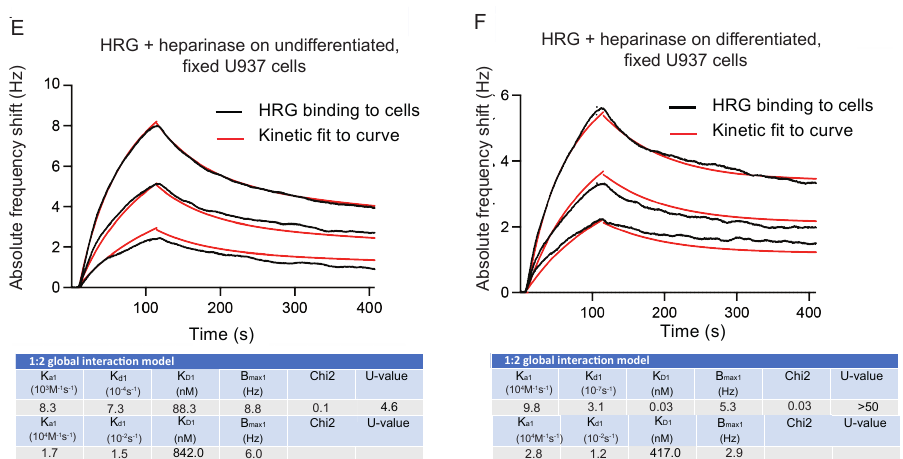
Figure 4. Affinity of HRG for binding to fixed U937 cells. ( A ) Sensorgram showing frequency response to inactive HRG over vitD3 differentiated, fixed U937 cells. ( B ) Sensorgram showing frequency response to four concentrations (125 nM, 250 nM, 500 nM, 1 µ M) of STC2 over fixed, undifferentiated (dashed lines) and vitD3 differentiated (straight lines) U937 cells. The mean of two injections is shown. ( C , D ) Sensorgram and kinetic analysis show the binding of HRG at three concentrations (25, 50 and 100 nM) to undifferentiated ( C ) or vitD3 differentiated ( D ), fixed U937 cells. Black lines: experimental curves. Red lines: fitted curves of the 1:1 interaction model. For representative sensorgrams shown, three injections per concentration, three independent experiments. ( E , F ) Sensorgram and kinetic analysis showing frequency response to three concentrations of HRG (25, 50 and 100 nM) to fixed, undifferentiated ( E ) or vitD3 differentiated ( F ) U937 cells after treatment with heparinase. Black lines: experimental curves. Red lines: fitted curves of 1:2 interaction model. For representative sensorgrams shown, three injections per concentration, three independent